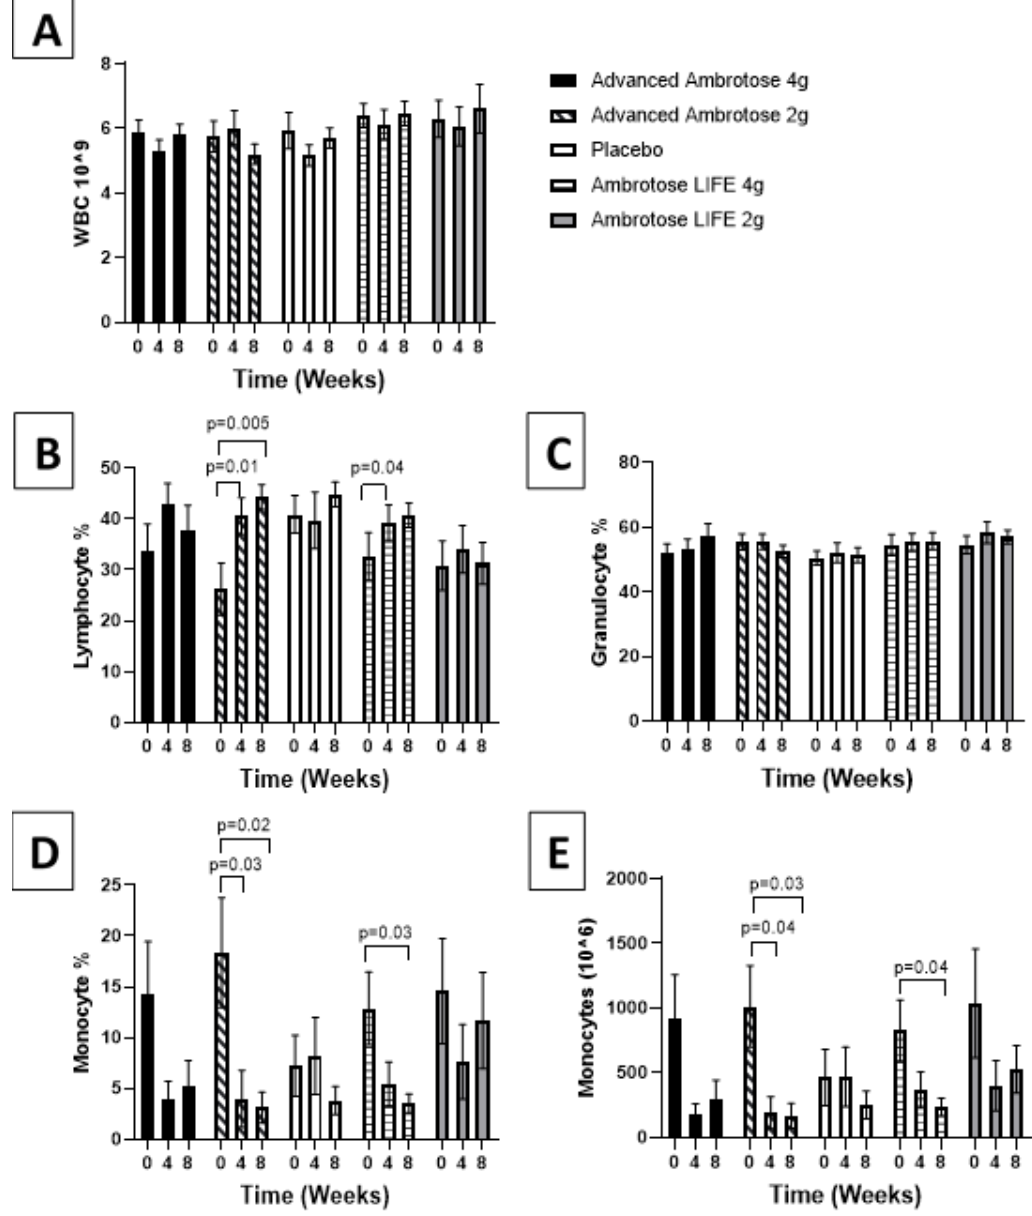
Figure 2. Hematological measurement determined at baseline and at four and eight weeks after supplementation. ( A ) Total white blood cell count. Fraction of lymphocyte ( B ), granulocytes ( C ), monocytes ( D ) of total circulating white blood cells. ( E ) Absolute monocyte count was calculated. Values are mean ± SEM, n = 15 per group. Significant changes are indicated where p < 0.05.